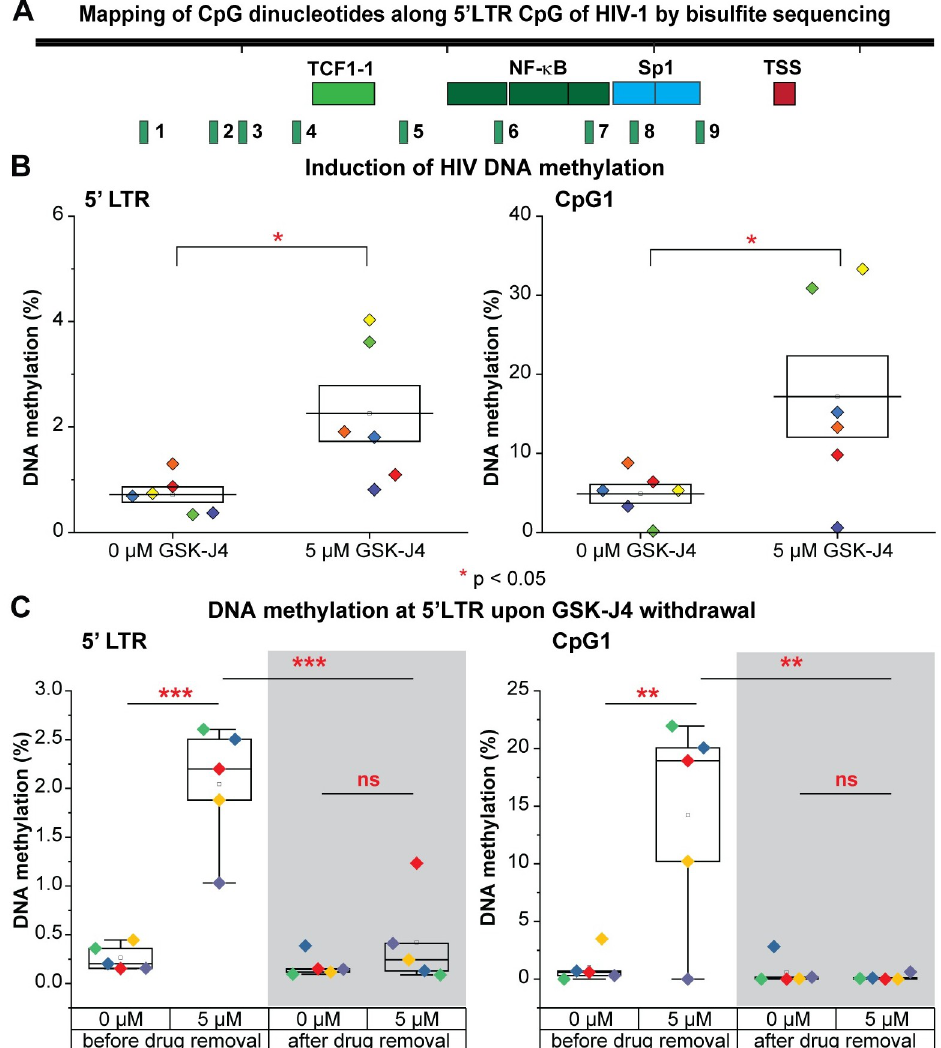
Fig 8. Temporary induction of DNA methylation at 5’LTR of latent HIV-1 in CD4 memory T cells upon the inhibition of UTX by GSK-J4. (A) The map of CpG dinucleotides (numbered from 1 to 9) relative to HIV-1 transcription start site along the 5’LTR CpG cluster. (B) The average DNA methylation (as %) of CpGs and the percentage DNA methylation at CpG island 1 of the 5’LTR CpG cluster from CD4+ memory T cells treated with the indicated concentration of GSK-J4. (C) The average DNA methylation of CpGs and the percentage DNA methylation at the CpG island 1 at the 5’LTR CpG cluster of HIV-1 from CD4+ memory T cells induced with GSK-J4 before or after GSK-J4 removal. Experiments were performed in single replicates with three different donors and in duplicates with one additional donor; One-tailed paired t-tests were performed on all experiments, � p < 0.05, �� p < 0.01, ��� p < 0.001, ns: not statistically significant. Note: different HIV-1 donors were utilized for this experiment than those utilized in Fig 8B.